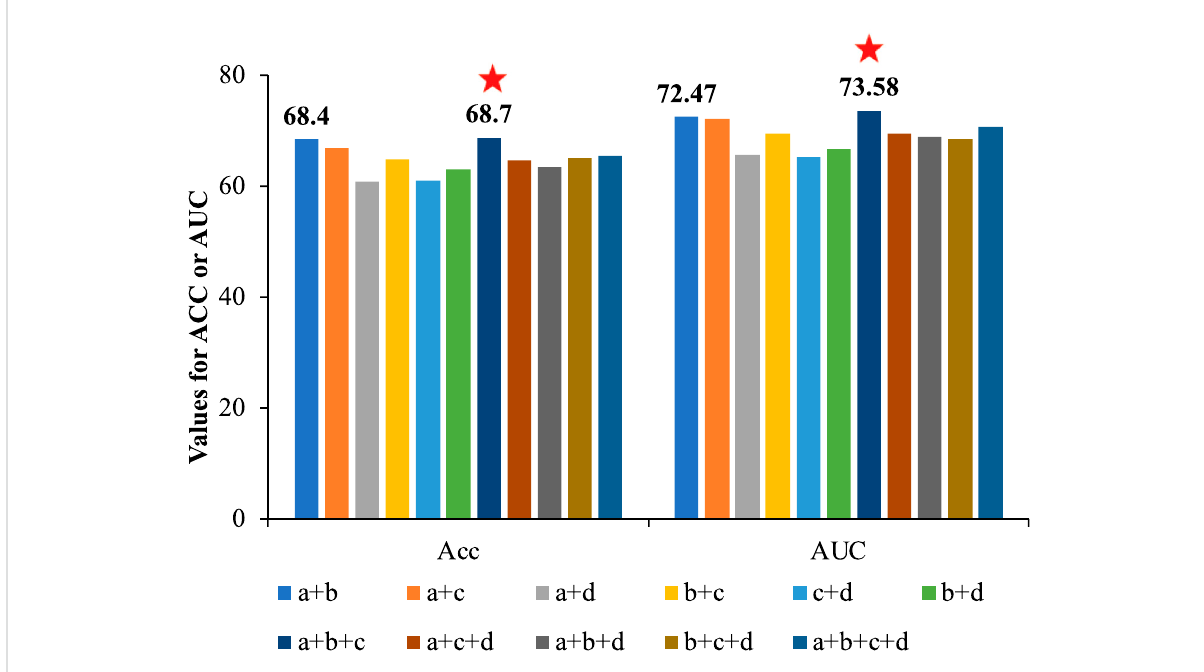
FIGURE 7 ThecomparisonofAccandAUCofdifferentfeaturecombinationsbasedonCNN.FeatureadenotedAPAAC,featurebdenotesCTDC,featurec denoted EGAAC, and feature d denoted embedding encoding. According to the results, the combination of a, b and c (EGAAC, APAAC and CTDC) showed the best performance.